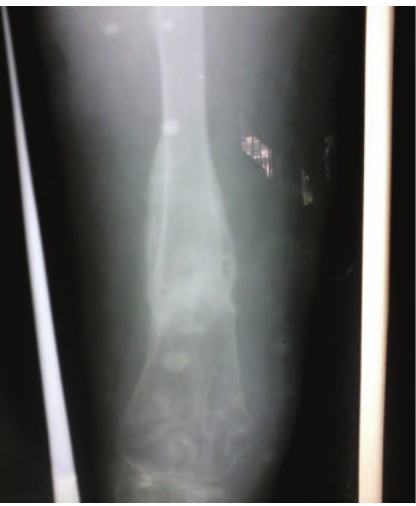
Figure 5: X-ray four and half months postoperative anteroposterior view, showing fracture consolidated.